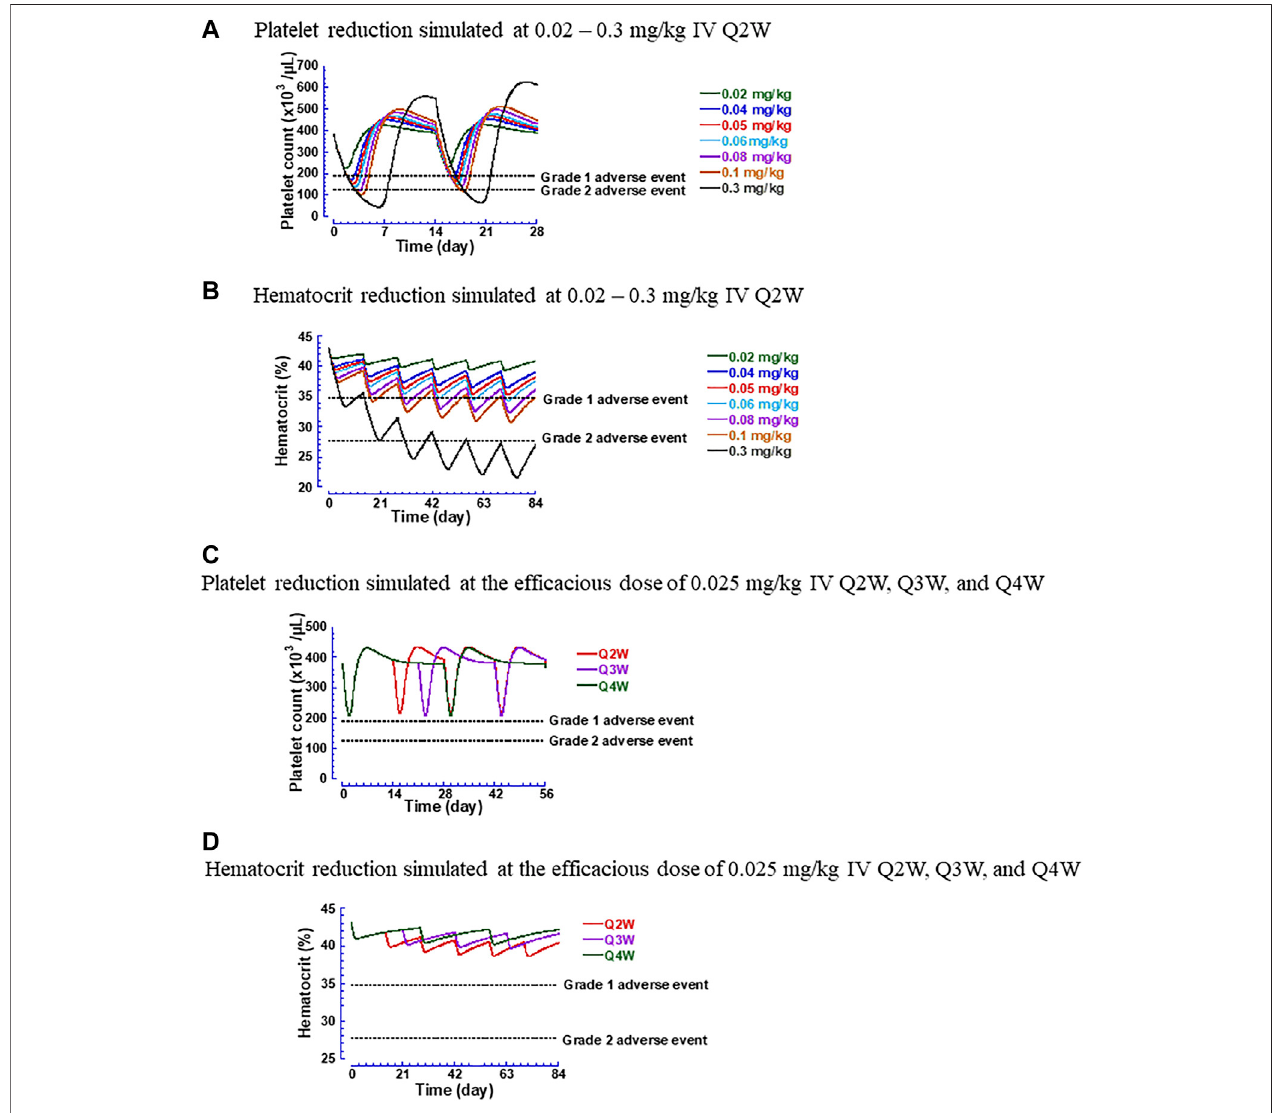
FIGURE 7 | Simulated hematological changes produced by hFc-hIL-10 in cynomolgus monkeys. (A) Platelet counts at the intravenous doses of 0.02 – 0.3 mg/kg given once every 2 weeks; (B) Hematocrit at the intravenous doses of 0.02 – 0.3 mg/kg given once every 2 weeks; (C) Platelet counts at the ef fi cacious dose of 0.025 mg/kgunderintravenousdosingregimensofevery2,3and4 weeks; (D) Hematocritattheef fi caciousdoseof0.025 mg/kgunderintravenousdosingregimensof every 2, 3 and 4 weeks. The Grades 1 and 2 adverse event lines are based on National Cancer Institute Common Terminology Criteria Adverse Events v5.0 and applied as the percentage of changes in hematological parameters to the baseline values estimated in cynomolgus monkeys.